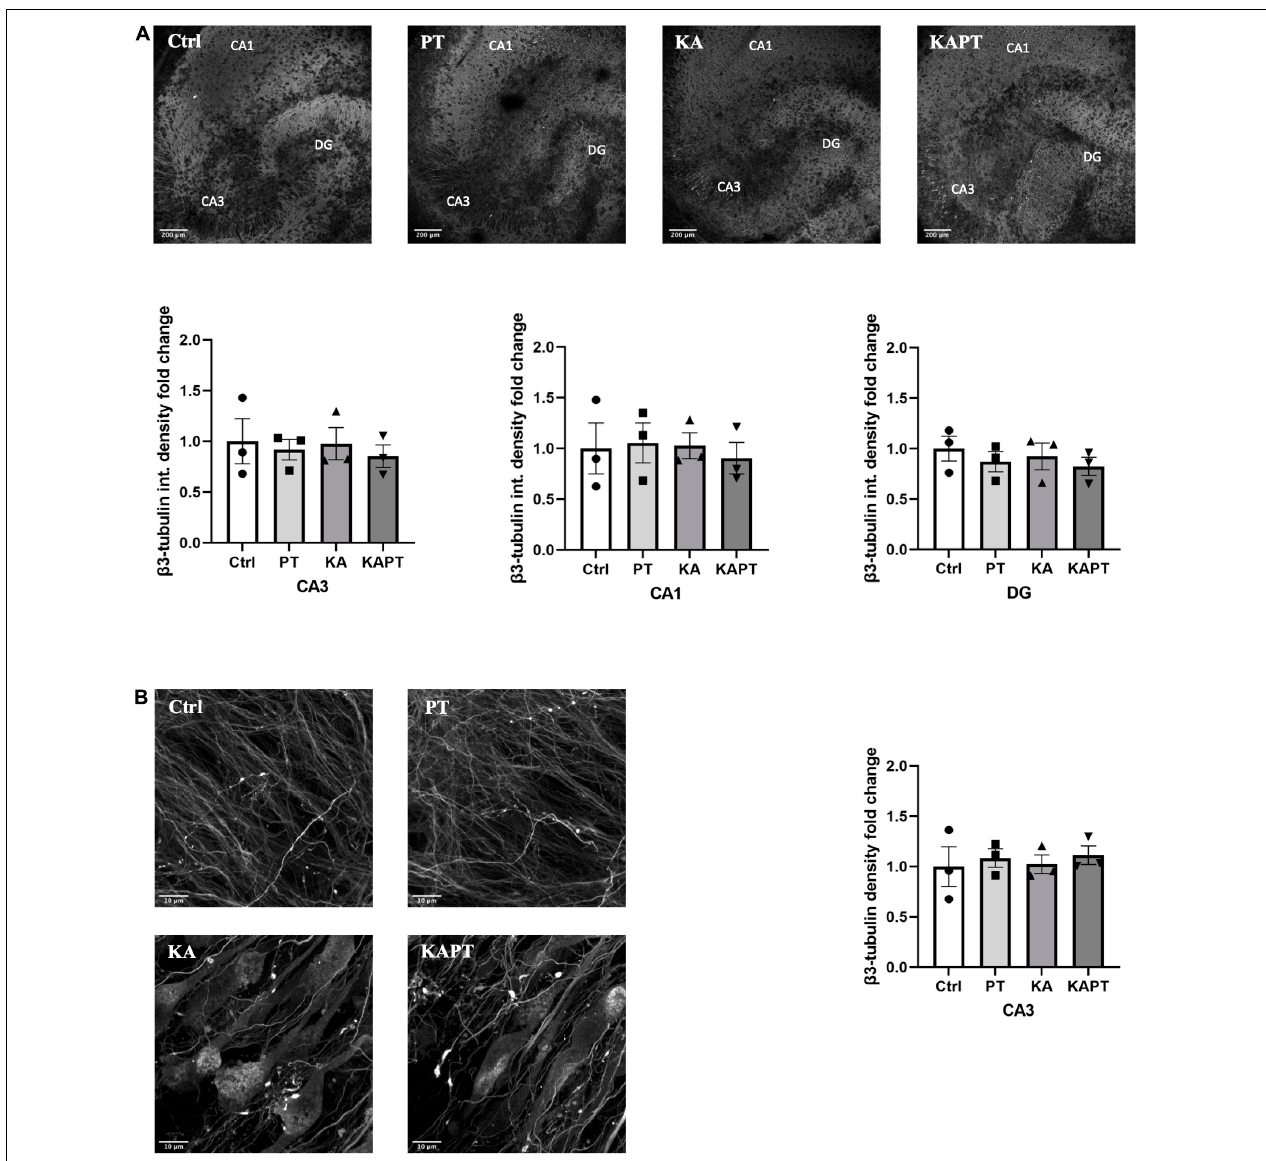
FIGURE 3 | Platinum nanoparticles (PtNPs) do not further impact neuronal integrity in normal and pathological conditions after 24 h of contact. (A) Representative beta-3 tubulin immunostaining of organotypic hippocampal slices under control conditions (untreated), PtNPs, kainic acid (KA) treatment, and KA treatment + PtNPs. Bottom charts represent the quantitative analysis of beta-3 tubulin fluorescence intensity in CA3, CA1, and dentate gyrus (DG). (B) Magnified images of CA3 region showing alterations in microtubule morphology only in KA-treated slices compared to controls, regardless of PtNPs incubation. Right chart represents the quantification of the b3-tubulin immunostaining in the high magnification CA3 area for the different slices. Data are expressed as integrated density fold change from the basal value of control slices and presented as mean ± standard error of the mean (SEM) ( n = 3 independent experiments; 4–6 slices analyzed per group/experiment). Tukey’s test after one–way analysis of variance (ANOVA) was used for statistical